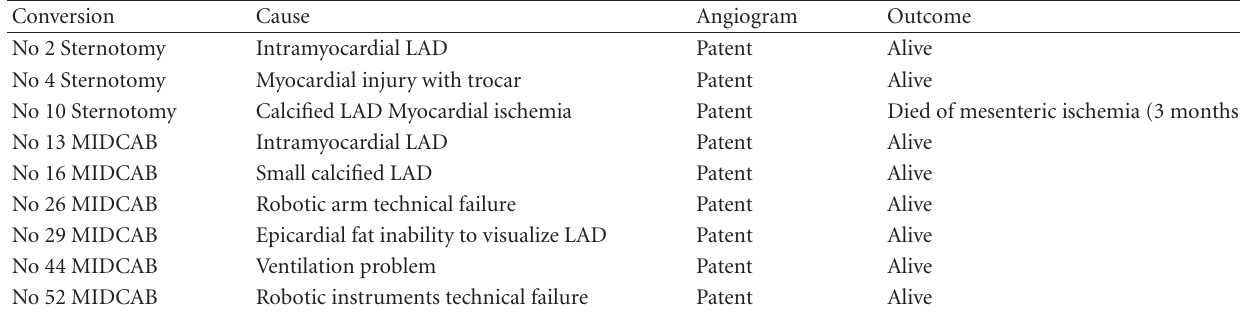
Table 2: Conversion and outcome.